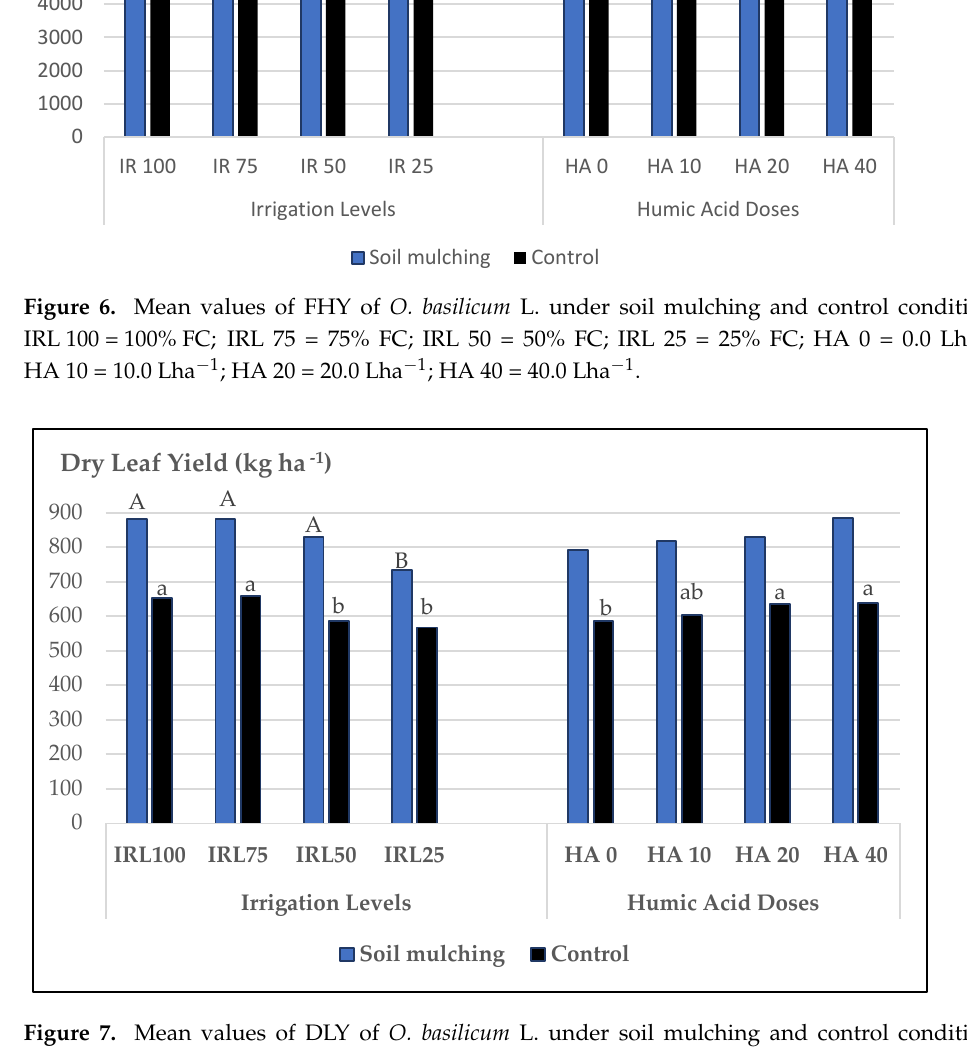
Figure 8. Mean values of EOY of O. basilicum L. under soil mulching and control conditions. IRL 100 = 100% FC; IRL 75 = 75% FC; IRL 50 = 50% FC; IRL 25 = 25% FC; HA 0 = 0.0 Lha − 1 ; HA 10 = 10.0 Lha − 1 ; HA 20 = 20.0 Lha − 1 ; HA 40 = 40.0 Lha − 1 . The summary of the fi rst and second trials is displayed in Table 6. As is seen in the table, the mean values of the fi rst trial belonging to the fi rst year were higher than those